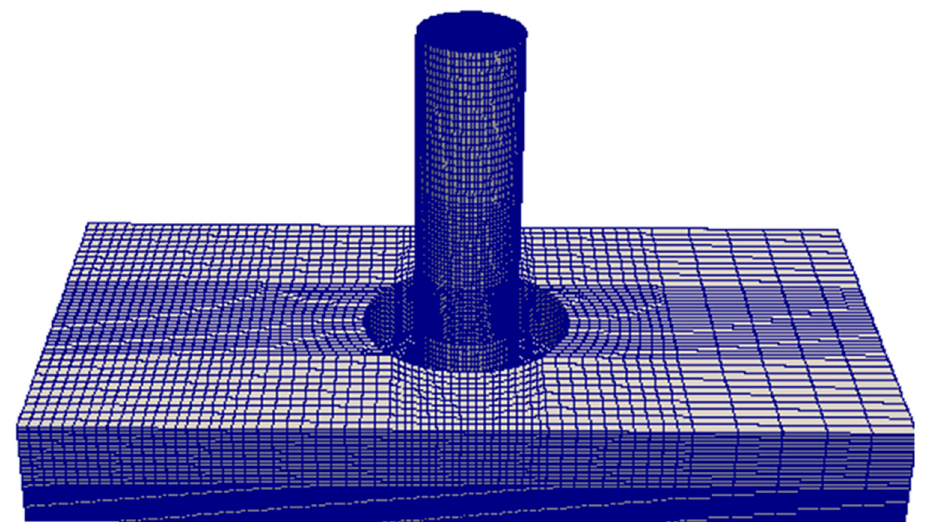
Figure 2. Discretization of the simulated system using hexahedral meshes.